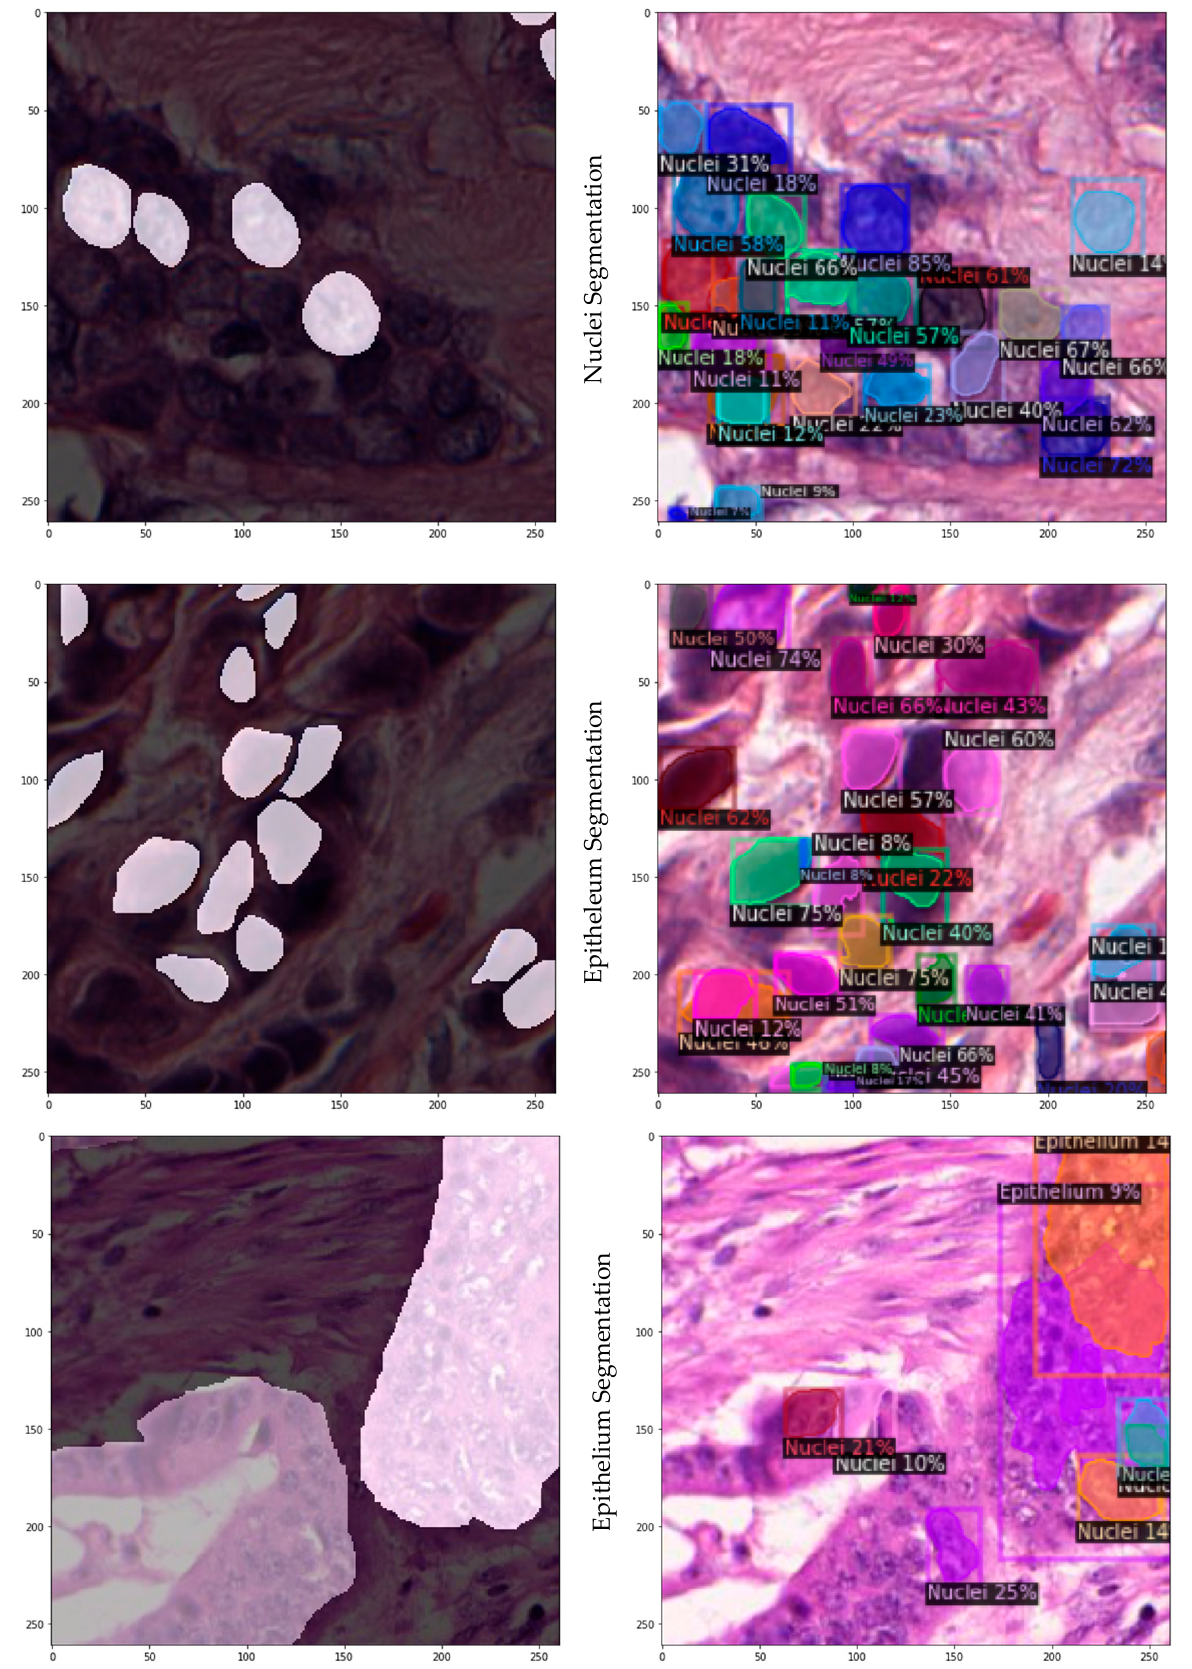
Figure 2. Sample WSIs from the test set with annotated ground truth ( left ) and predictions ( right ).